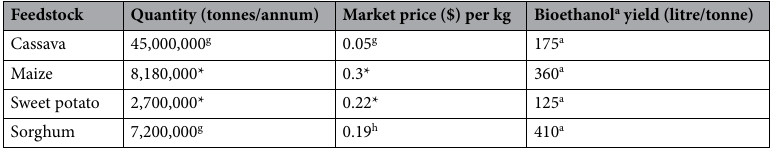
Table 3. Availability and cost of first-generation bioethanol feedstocks in Nigeria. Sources: a20 ; g37,38 ; h39 ; * 40 .